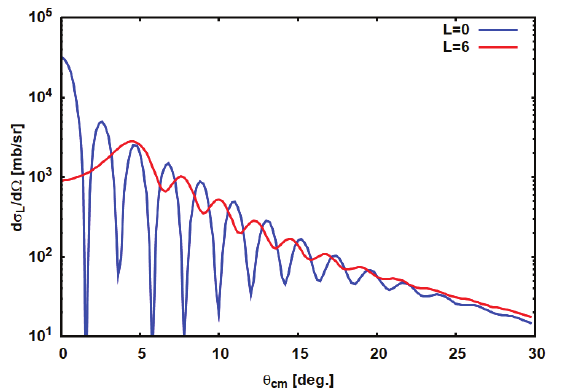
Figure 3. First-order SCE unit strength cross sections for the reaction 18 O + 40 Ca → 18 N + 40 Ar at T lab = 270 MeV. The angular range corresponds to momentum transfers up to 1000 MeV/c. Optical potentials and transition potentials are calculated in a double folding approach by using the (newly derived) nucleon–nucleon (NN) T-matrix at T lab = 15 MeV, parameterized as in References [24,25]. Optical potentials are calculated with Hartree–Fock–Bogoliubov (HFB) ground state densities accord- ing to Reference [18]. The cross sections are calculated by using average form factors derived from QRPA transition densities as discussed in the